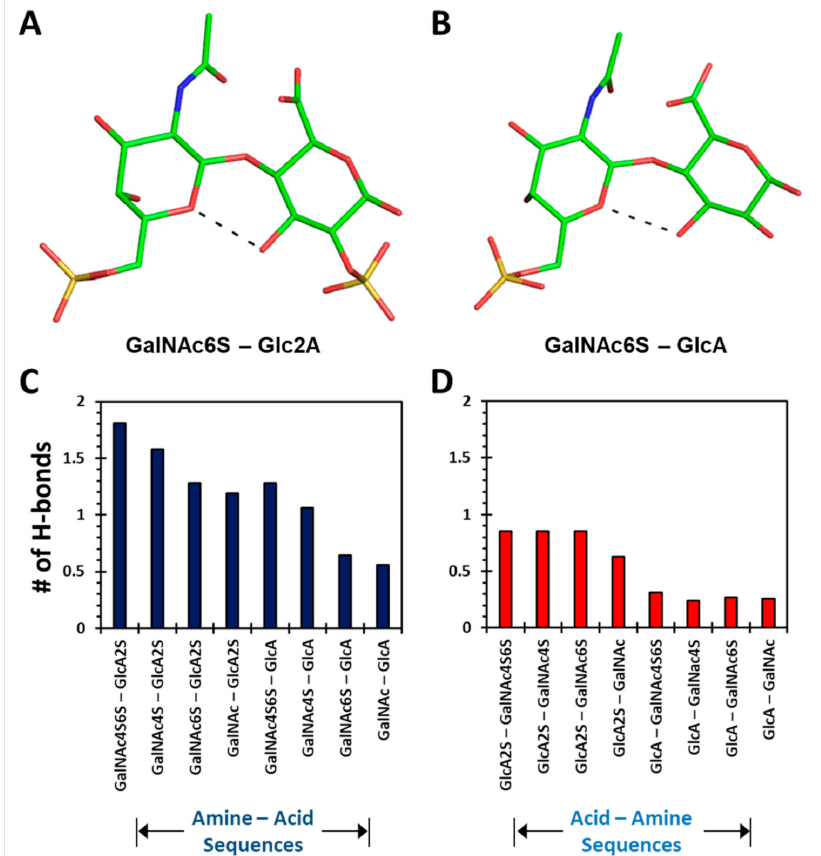
Figure 4. Differences in intra-molecular hydrogen bonds observed during MD simulations of different 1 → 4- and 1 → 3-linked sequences (hydrogens are not shown to improve clarity). ( A , B ) show intra- molecular H-bonds formed for two representative disaccharides, GalNAc6S–GlcA2S and GalNAc6S– GlcA, respectively. ( C , D ) show the average number of intra-molecular H-bonds calculated from the 20,000 frames of each MD trajectory of 8 CS disaccharides of either Amine–Acid (1 → 4) or Acid– Amine (1 → 3) type, respectively. Whereas intra-molecular H-bonds are formed between atoms of the CS disaccharide, inter-molecular H-bonds are formed with solvent water molecules. The criteria for defining a H-bond is described in the Methods